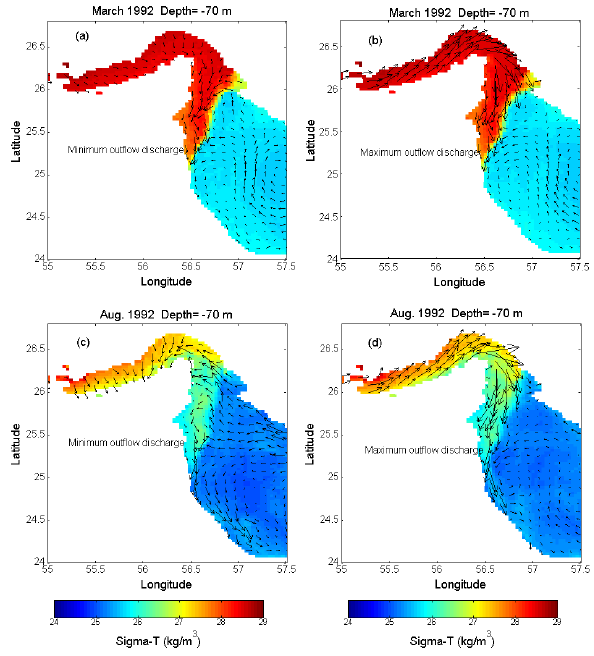
Fig. 22. The snapshots of σ - T and velocity fields in the minimum and maximum outflow transports during March and